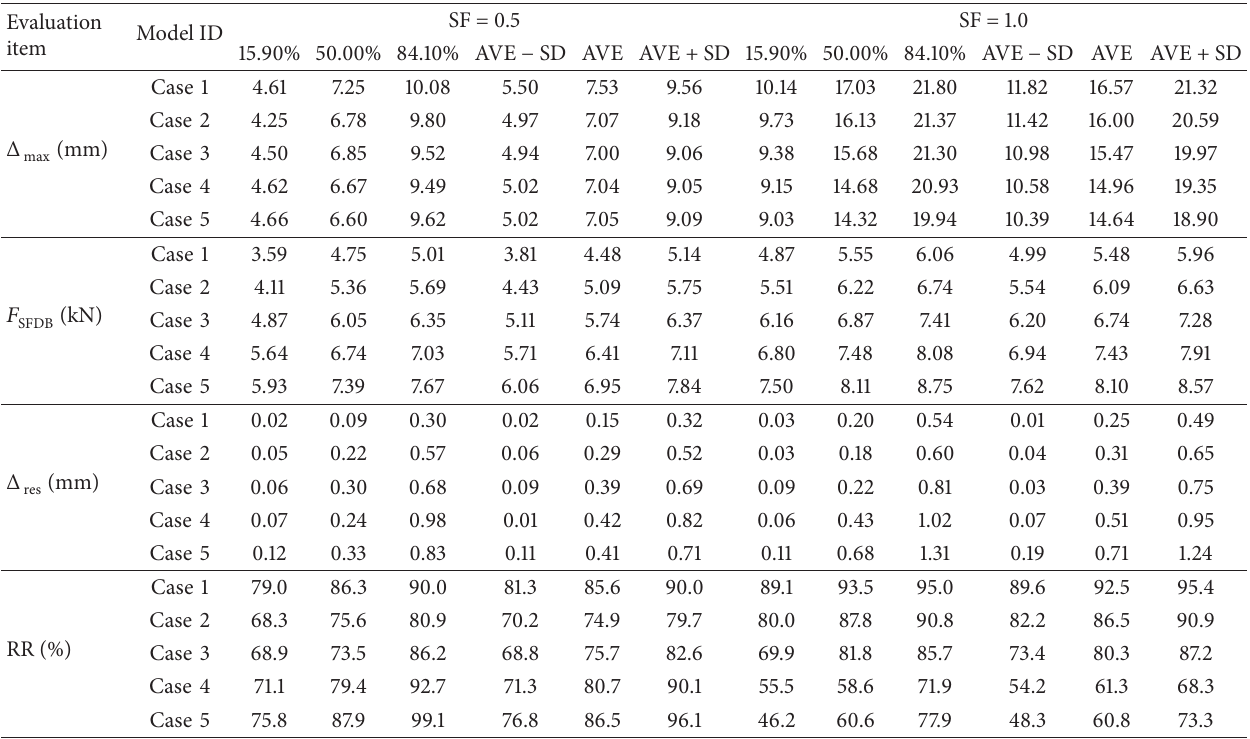
Table 4: Summary of statistical values for individual model cases under 10% in 50-year ground motions. Evaluation